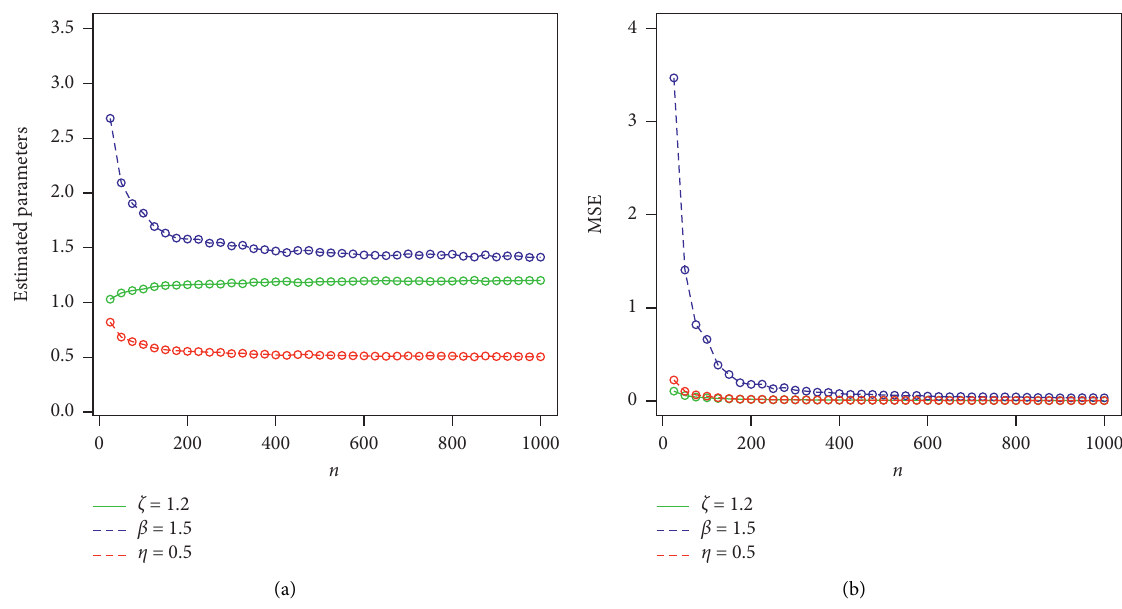
Figure 8: Graphical display of the simulation results provided in Table 2. (a) Plot of estimated parameters vs. n. (b) Plot of MSEs vs. n .